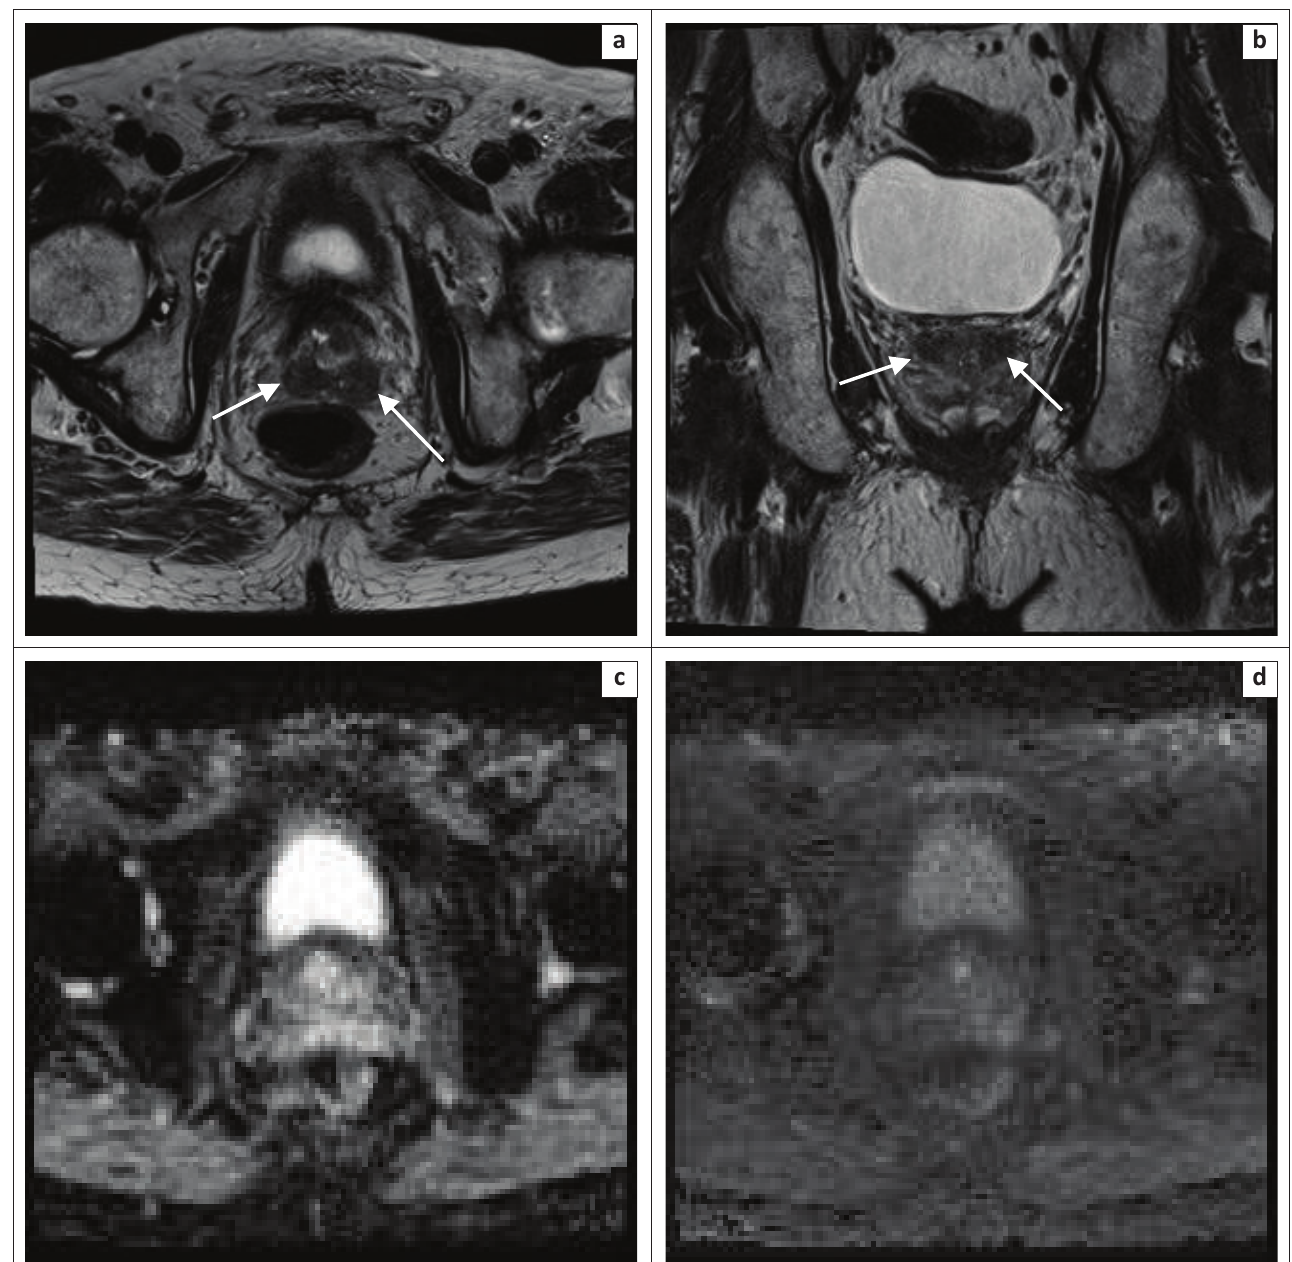
FIGURE 8: Central zone (a, b, c and d). At the prostate base the central zone is homogeneously T2